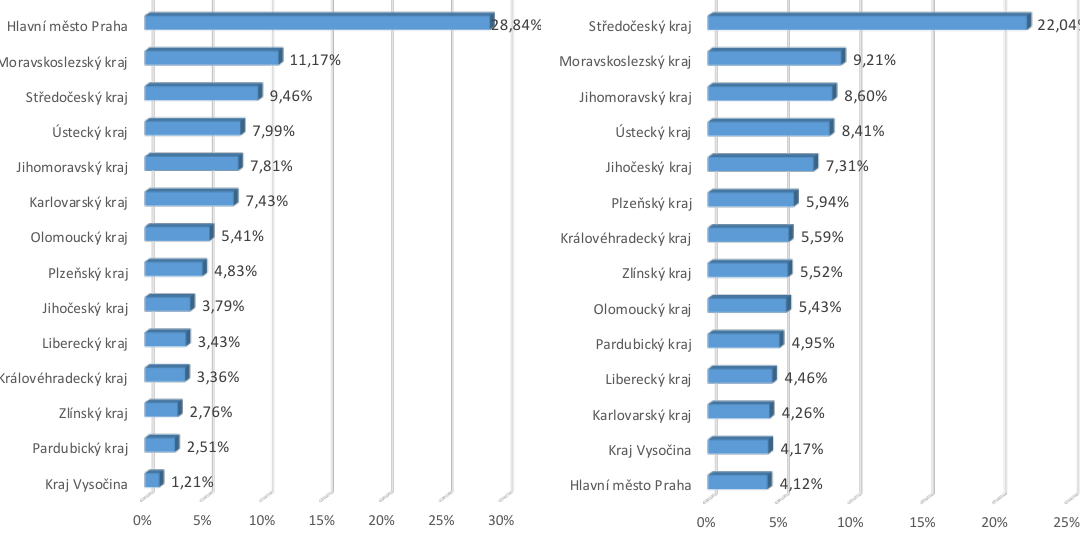
Graf 3 a 4: Struktura cenových nabídek podle kraje - počet nabídek bytů k prodeji (levý graf), počet nabídek